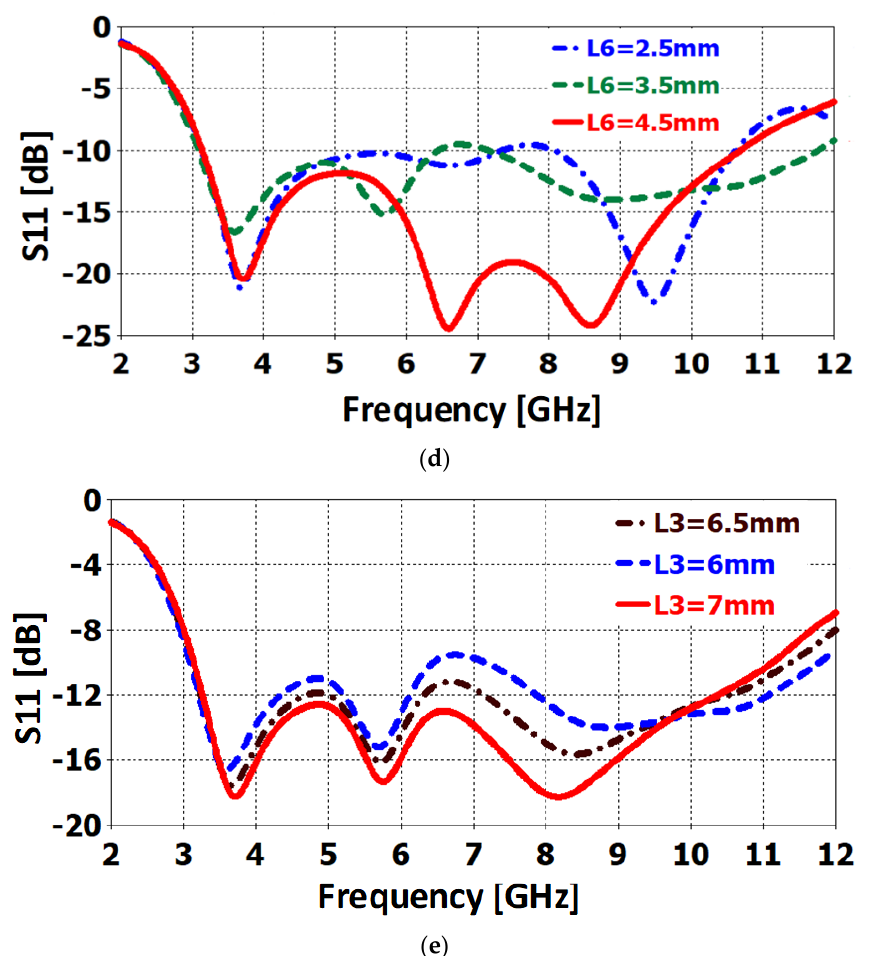
Figure 4. Different parameters optimization: ( a ) variation in “Lg”, ( b ) variation in “wg”, ( c ) variation in “wf”, ( d ) variation in “L6”, ( e ) variation in “L3”.